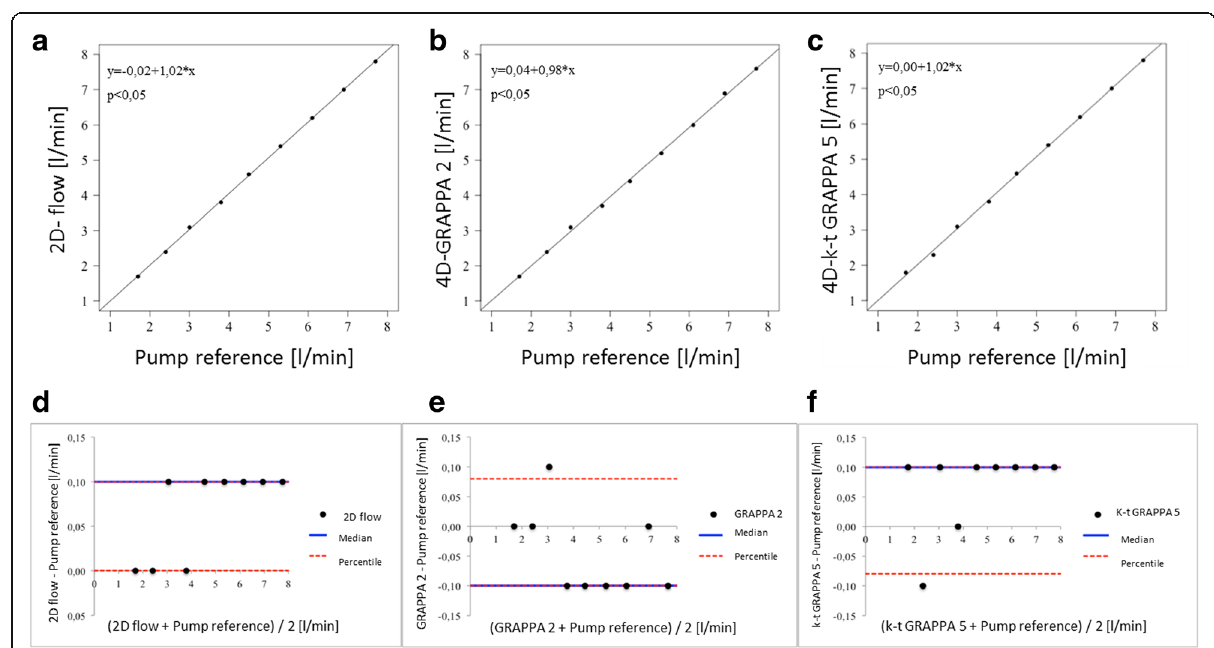
Fig. 3 Scatter plots of the correlation between flow volumes [L/min] measured with ( a ) the 2D flow sequence, ( b ) the 4D flow GRAPPA2 sequence, and ( c ) the k-t- GRAPPA5 sequence versus the pump reference. The correlation coefficient R was 0.99 for each of the graphs. Bland- Altman analysis of flow volumes [L/min] measured with ( d ) the 2D flow sequence, ( e ) the 4D flow GRAPPA2 sequence, and ( f ) the k-t- GRAPPA5 sequence versus the pump reference the limits of agreement (LOA) between the flow volumes [L/min] in ( d ) 2D PCMRI, ( e ) GRAPPA2, and ( f ) k - t - GRAPPA5 and the pump reference. The limits of agreement were from 0.0 to 0.1, from − 0.1 to 0.08, and from − 0.08 to 0.1 L/min, respectively. 2D, two-dimensional; 4D, four-dimensional; GRAPPA, generalised autocalibrating partially parallel acquisition; L/min, litres per minute